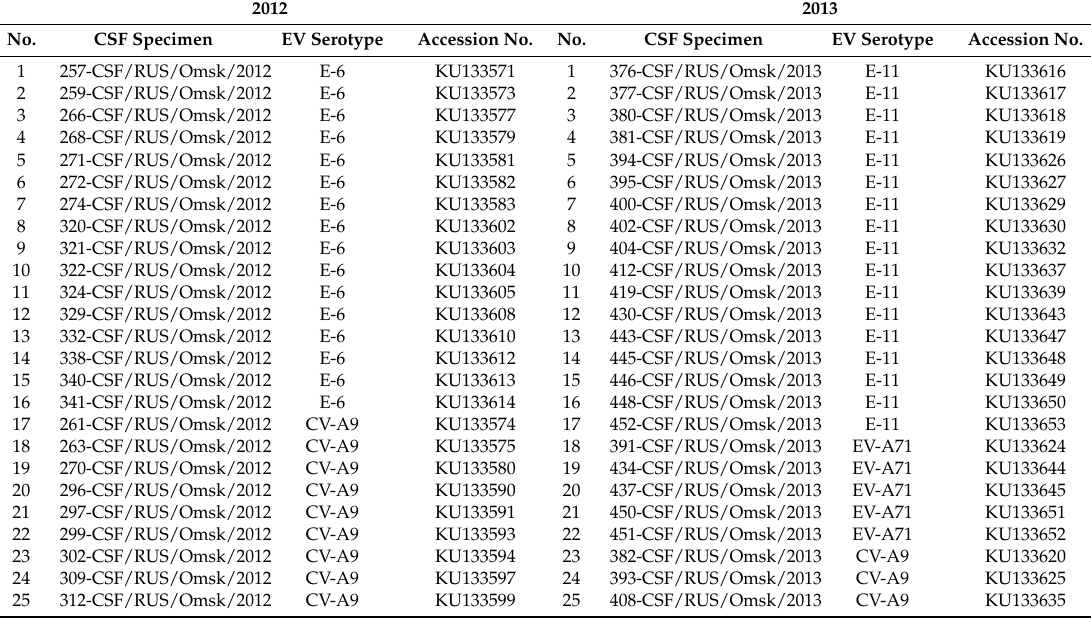
Table 2. Direct serotyping of enteroviruses detected in cerebrospinal fluids (CSFs) of patients with serous meningitis admitted in 2012 and